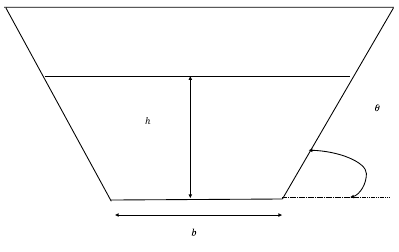
Fig. 1 Channel cross section area: Here, h , b , and 𝜃 are flow depth, bottom width, and trapezoidal